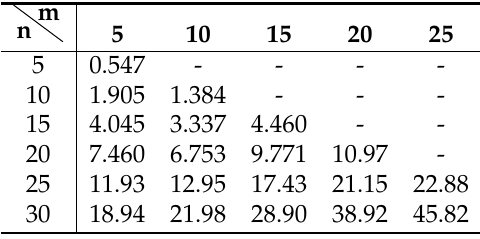
Table A6. Total solution time using Chebyshev polynomials in seconds for Problem #2.